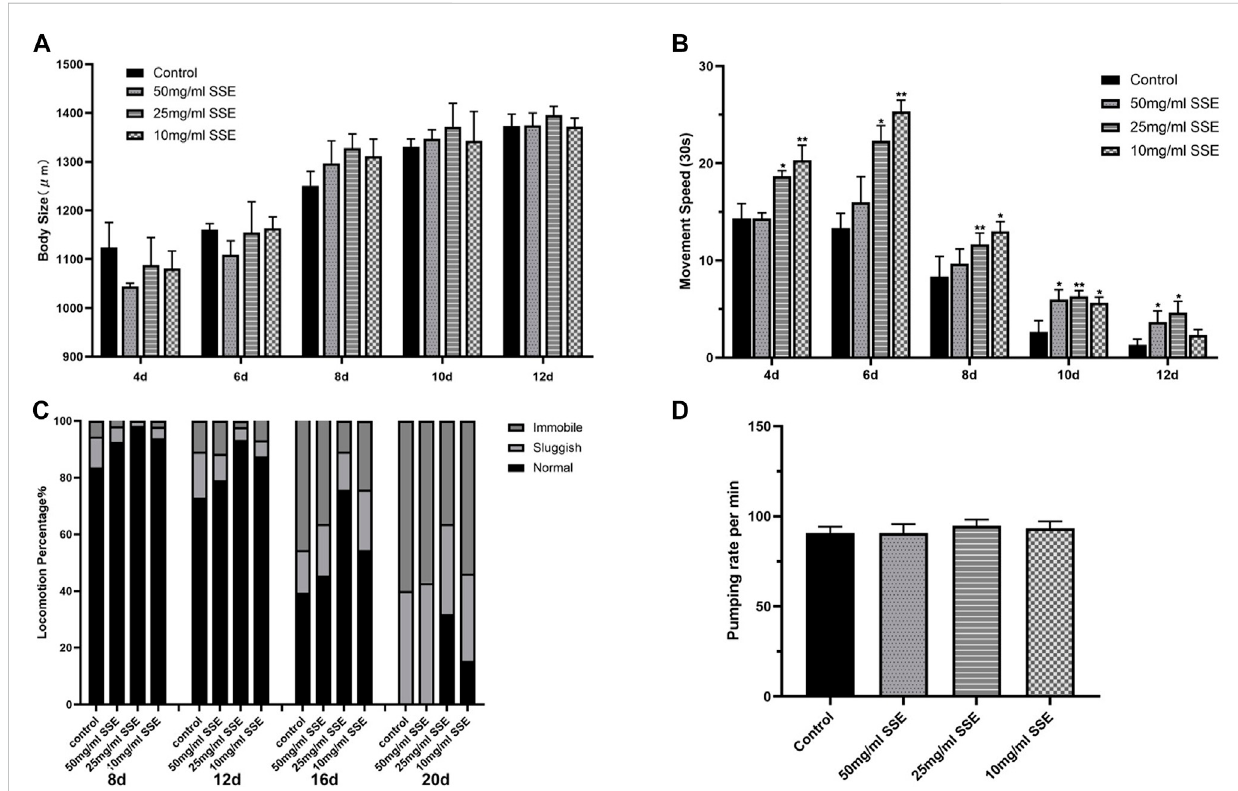
FIGURE 4 EffectsofSSEonthePhysiologicalResponsesof Caenorhabditiselegans .Measurementsofbodysize (A) andmovementspeed (B) fromday4today 12. (C) Effect of SSE on the motility of Caenorhabditis elegans . Motility was classi fi ed into three groups: Normal, worms exhibit spontaneous sinusoidal motions; Sluggish, worms move after touched; Immobile, hardly any movement. (D) Effect of SSE on pharyngeal pumping rate in N2 worms. * p ≤ 0.05, ** p ≤